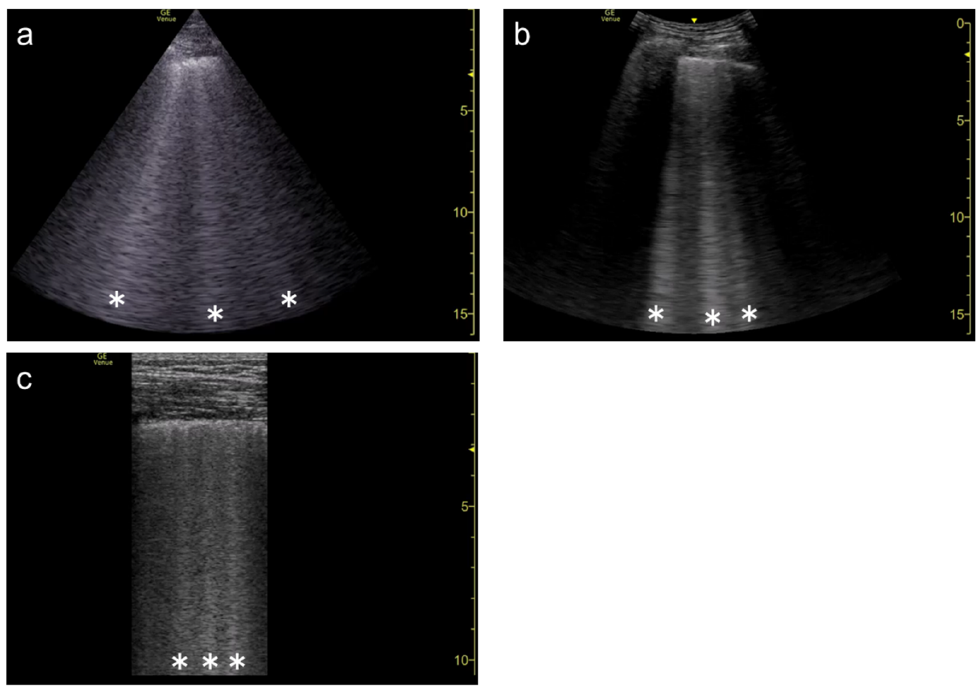
Figure 10. Ultrasound images obtained with Venue scanner (GE Healthcare) with a sector ( a ), curvilinear ( b ), and linear ( c ) transducers in cardiogenic pulmonary edema. Asterisks indicate B-lines.